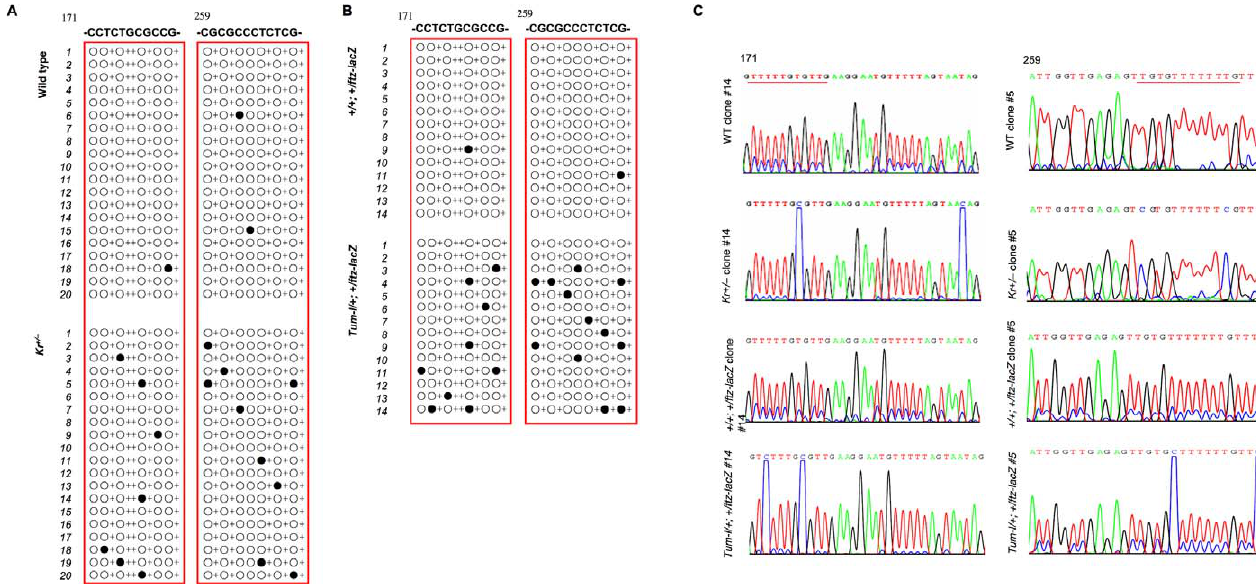
Figure 4. Methylation of CG/T ‘‘ Islands ’’ in the ftz Minimal Enhancer Genomic DNA isolated from animals of different genotypes was treated with sodium bisulfite and independent clones of the ftz-lacZ were sequenced. Sequencing results of two CG- or CT-rich boxes in the ftz minimal enhancer from animals of indicated genotypes are shown in red boxes, with the original sequences on top. Numbers above the sequences indicate positions from the forward PCR primer (see Figure S2 for primer sequence). Numbers to the left indicate sample numbers of independent clones. Unmethylated C’s, which are converted to T’s following bisulfite treatment, are indicated by open circles. Methylated C’s, which remain as C’s following bisulfite treatment, are represented as filled circles. (A) Genomic DNA was isolated from Kr 1 / CyO ftz-lacZ and þ /CyO ftz-lacZ (wild-type control) adult flies (clones 1–15) and embryos (clones 16–20), and (B) from embryos of Kr 1 /CyO ftz-lacZ males crossed to hop Tum-l/ þ females or wild-type females. Note that there are more unconverted C’s in lower panels, indicating higher levels of methylation in these samples. Low background levels ( , 1%) of unconverted C’s were found in other regions for both samples. (C) Sample chromatograms with clone number indicated. doi:10.1371/journal.pgen.0030151.g004 DNA methyltransferase inhibitor 5-aza-2 9 -deoxycytidine (5- aza-dC) and determined the effects of drug treatment on hop Tum-l –dependent blood tumor formation. When raised at 100 l M 5-aza-dC (a nonlethal dose), hop Tum-l/ þ flies exhibited